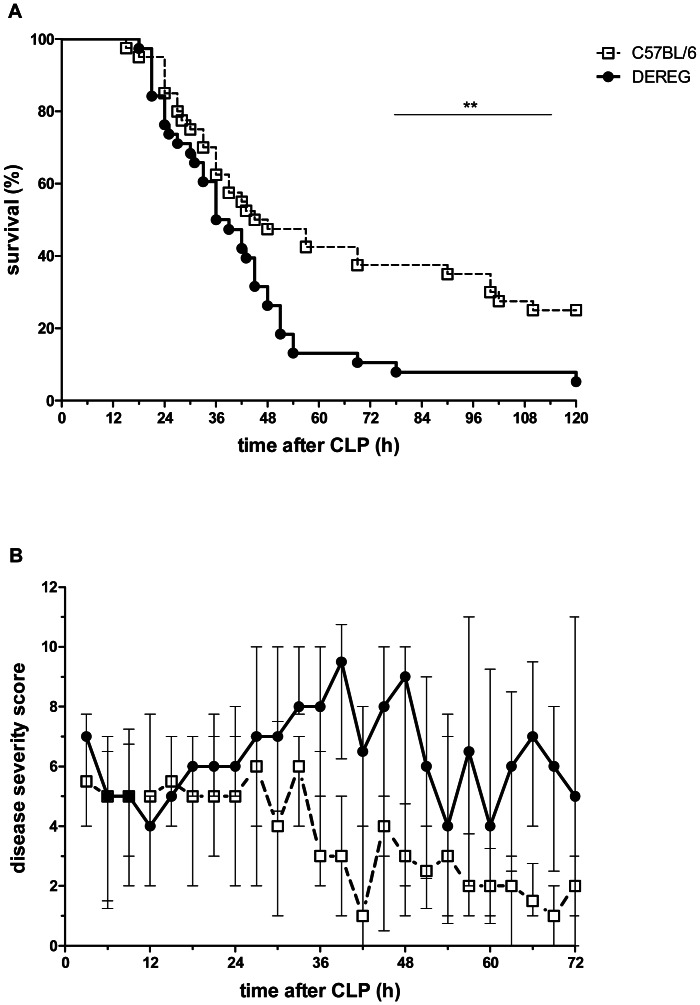
Treg-depletion augmented disease severity and decreased survival in CLP-treated mice.DEREG and C57BL/6 mice pre-treated with DT (1 µg in 100 µl PBS i.v. on days −2 and −1) were subjected to CLP. Survival was monitored for 5 days (A) and disease severity was scored for 3 days (B) by an observer blinded for the group assignment. Data from four independent experiments with similar results are summarized (each experiment involved 8–11 mice/group). Median and interquartile range of the disease severity score are shown in panel B; ** p<0.01.